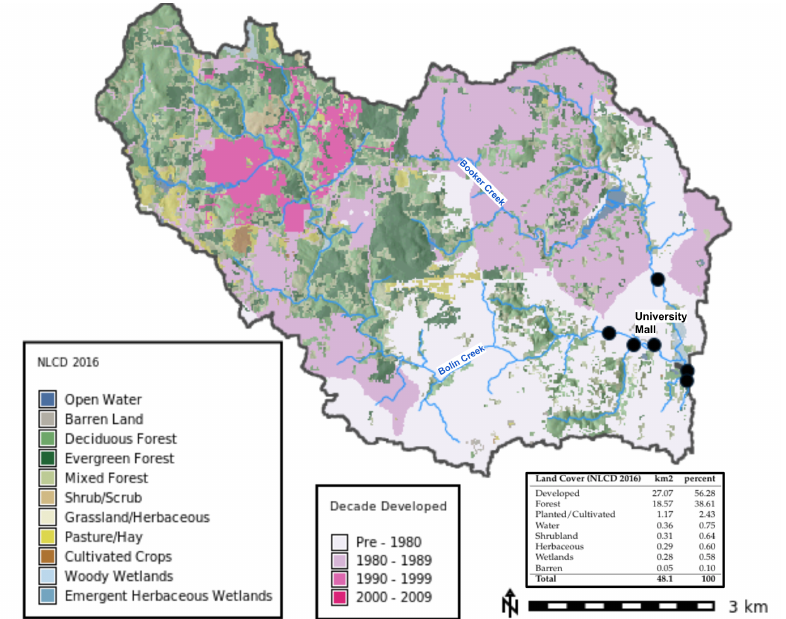
Figure 10. Cluster 1—Cluster 1 (University Mall) has an upstream contributing area of 48.1 km 2 that is 56% developed. The cluster was developed before the 1980s, with University Mall opening in 1973. After this initial development, an additional 14 km 2 of developed land was added upstream, contributing to the current flood conditions identified by stakeholders.